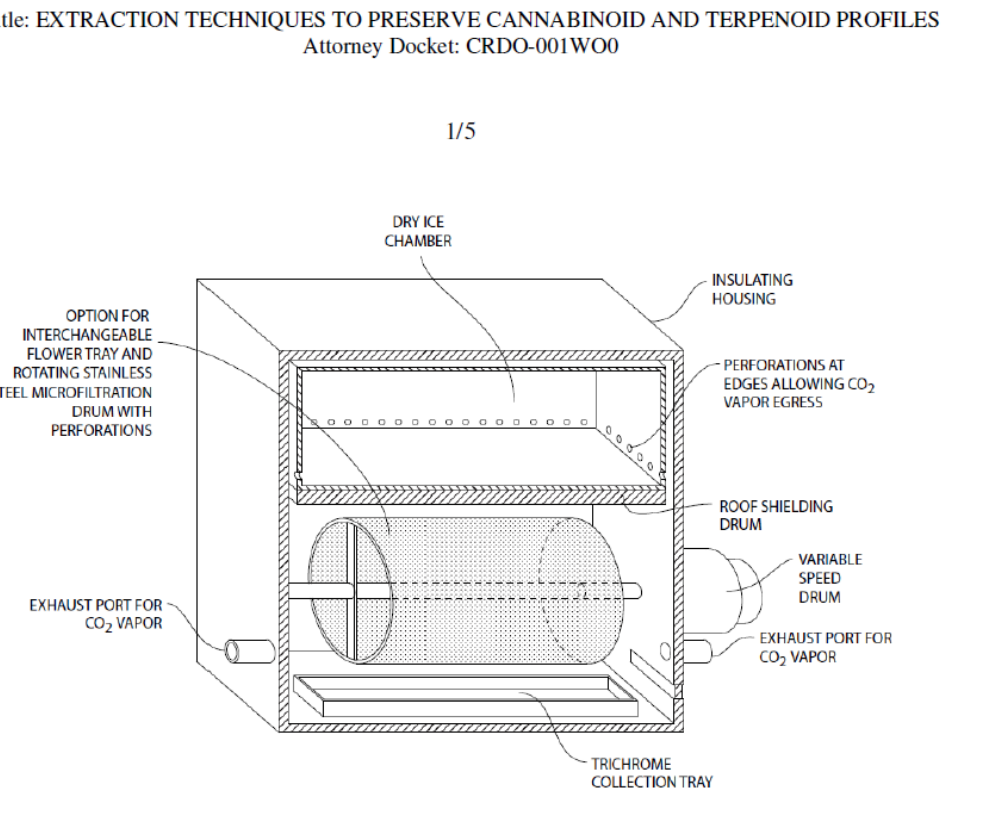
Figure 12. Prototype unit for Kryo-Kief™ extraction (Patent Pending, © 2021 Ethan Russo and CReDO Science). Figure 13. Prototype unit for Kryo-Kief™ extraction (Patent Pending, © 2021 Ethan Russo and CReDO Science). For extract cannabinoid analysis, the samples were homogenized using a stir rod, weighed out 50 mg into a Falcon tube, 5 mL of HPLC-grade methanol, vortexed for 15 min, centrifuged at 3000 RPM for 10 min and finally diluted 50 µ L of the extract into 950 µ L of HPLC-grade methanol for a 1:20 dilution (100-fold dilution factor). The samples were analyzed via a 1 µ L injection onto a column (Restek Raptor ARC-18 150 mm × 4.6